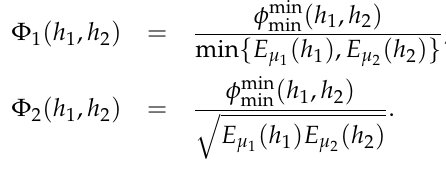
Table 5. Values of the function h min